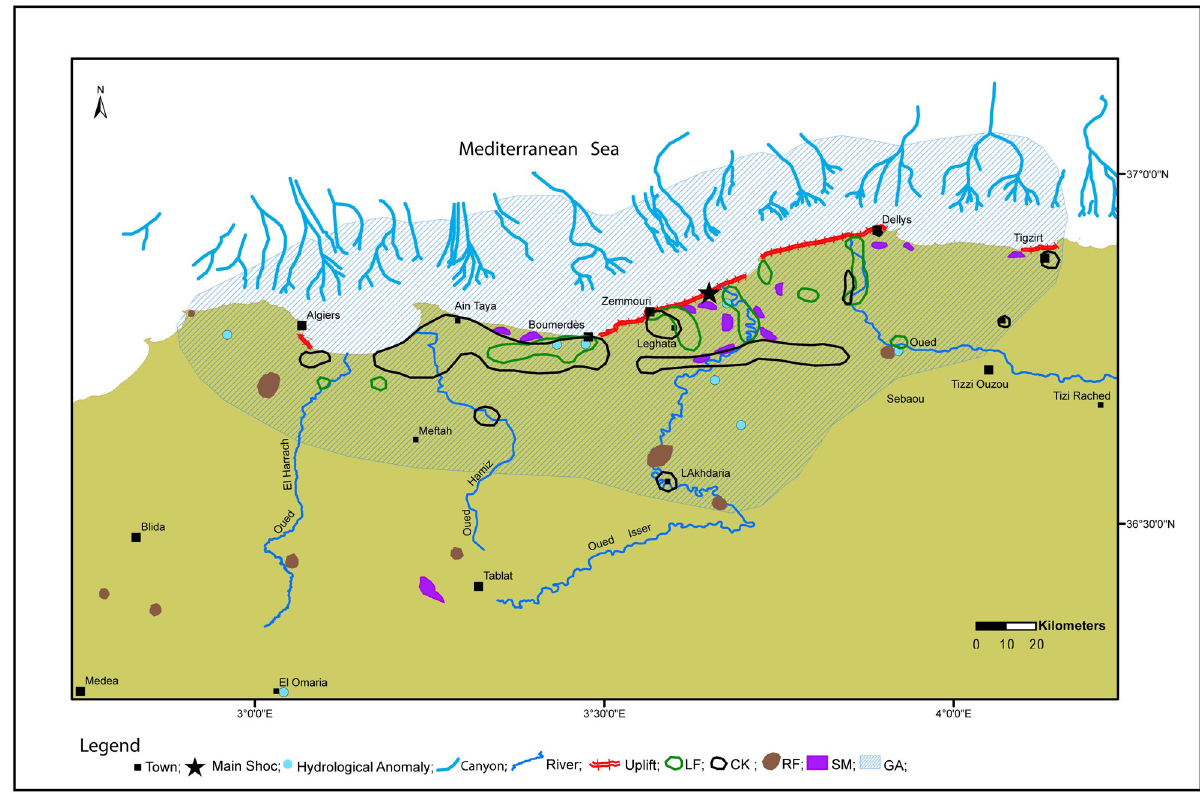
Figure 3. The 2003 Boumerdès earthquake geological effects distribution based on survey data from authors cited in the text, and the cal- culated global area. LF: liquefaction; CK: cracks; RF: rock falls; SM: slope movements; GA: global